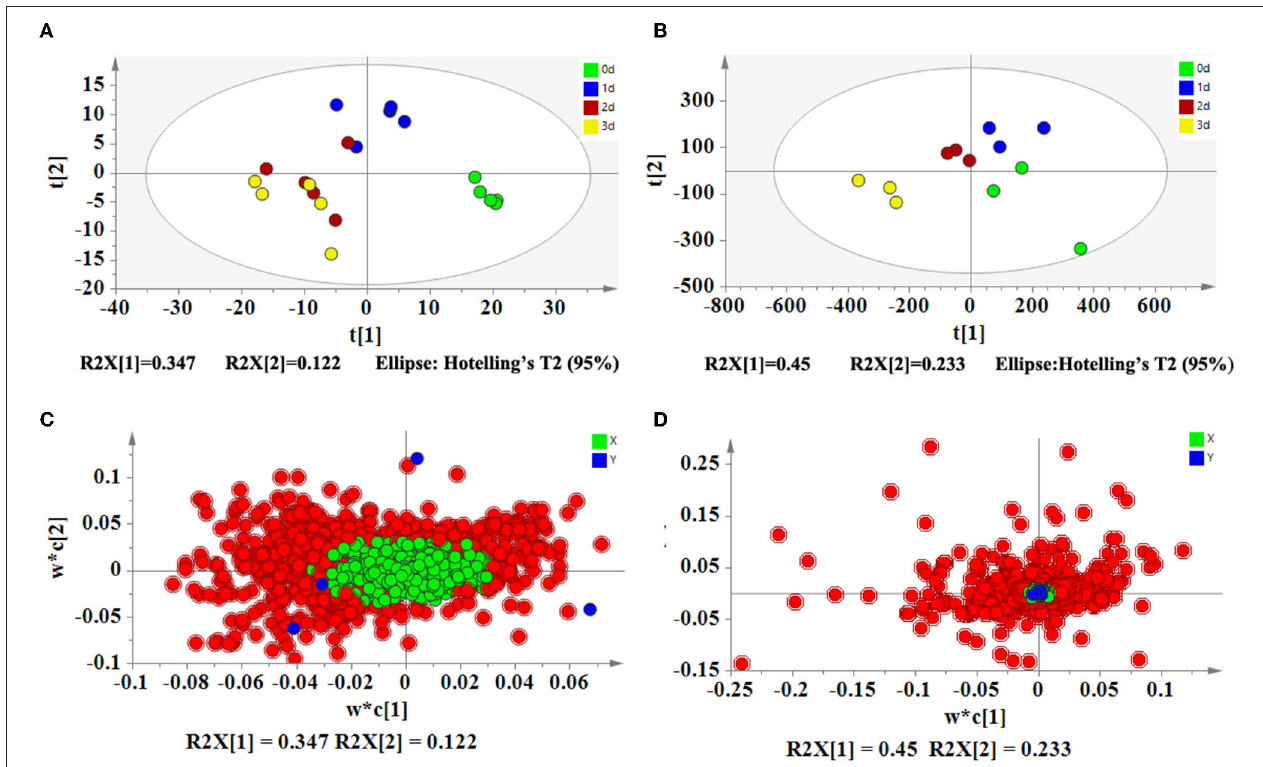
FIGURE 2 | PLS-DA analyses of metabolomics and transcriptomics of pitaya pollen under low-temperature storage. (A) PLS-DA score plot of metabolomics. (B) PLS-DA score plot of transcriptomics. (C) PLS-DA loading plot of metabolomics. (D) PLS-DA loading plot of transcriptomics. PLS-DA score plots (A,B) show that four groups (days 0, 1, 2, and 3) are located in different regions, indicating that the metabolites and genes are changed significantly during storage. The results of PLS-DA loading plots (C,D) show that the important metabolites and genes (VIP > 1) are in